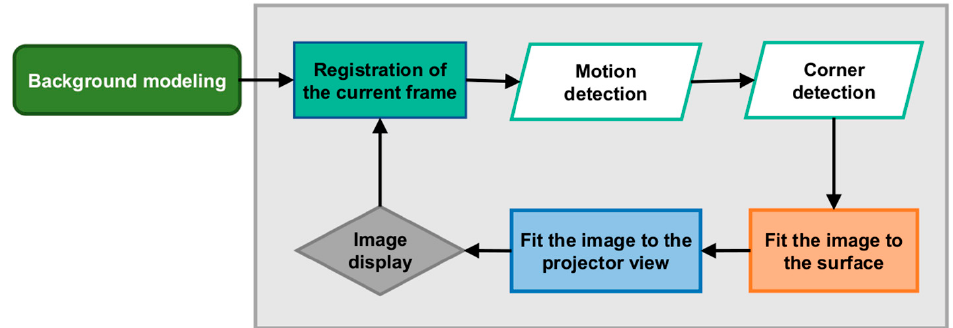
Figure 7. Diagram of the mapping process of moving rectangular surfaces.